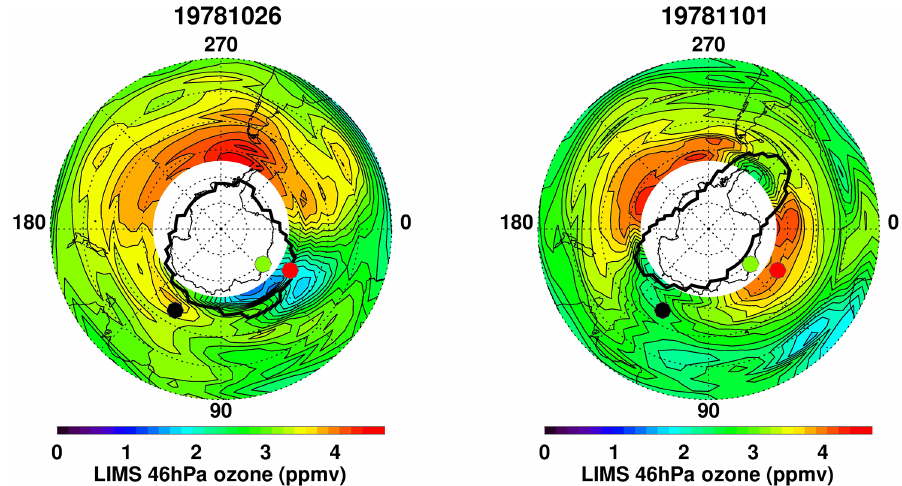
Figure 2. V6 ozone mixing ratios at 46.4hPa for 26 October and 1 November 1978. Polar plots extend from 30 ◦ S to the South Pole and longitude is in ◦ E with 0 ◦ at right. Bold contours denote the vortex edge from ERA-40. The superposed, three colored dots correspond to the locations of profiles on 26 October (black and red) and on 3 September (green) in Fig. 3.